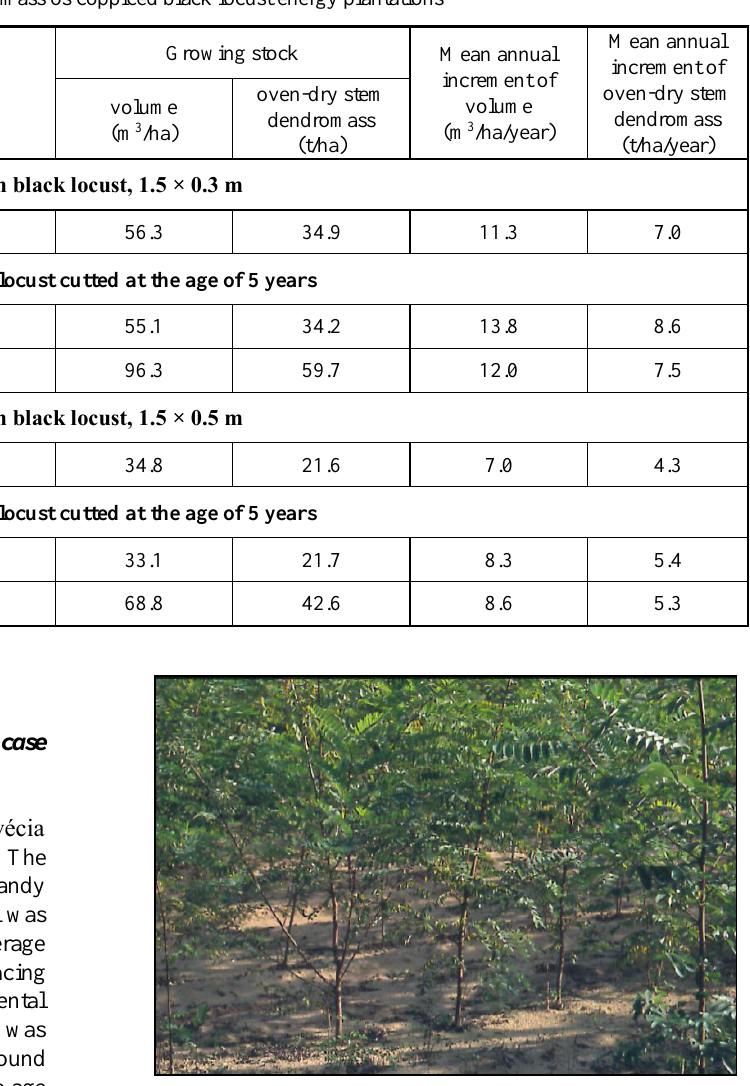
Figure 1. One year old black locust energy